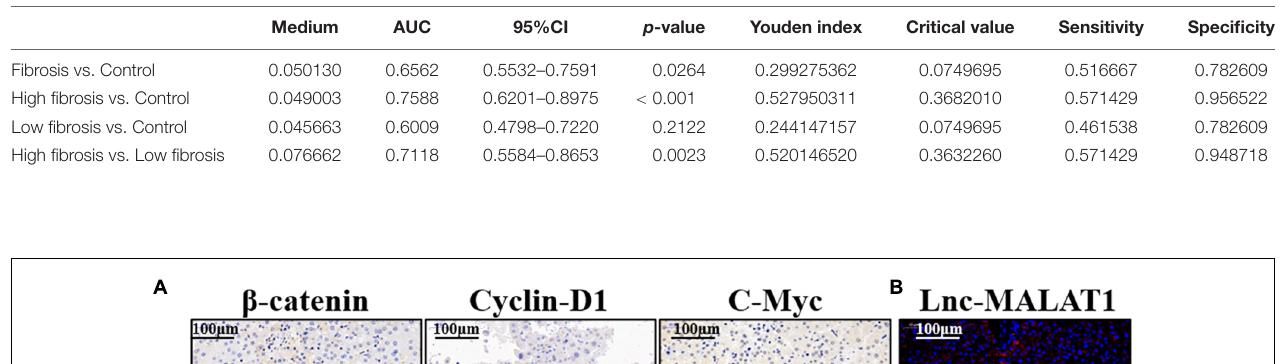
TABLE 1 | Diagnostic values of Lnc-MALAT1 for liver fibrosis.